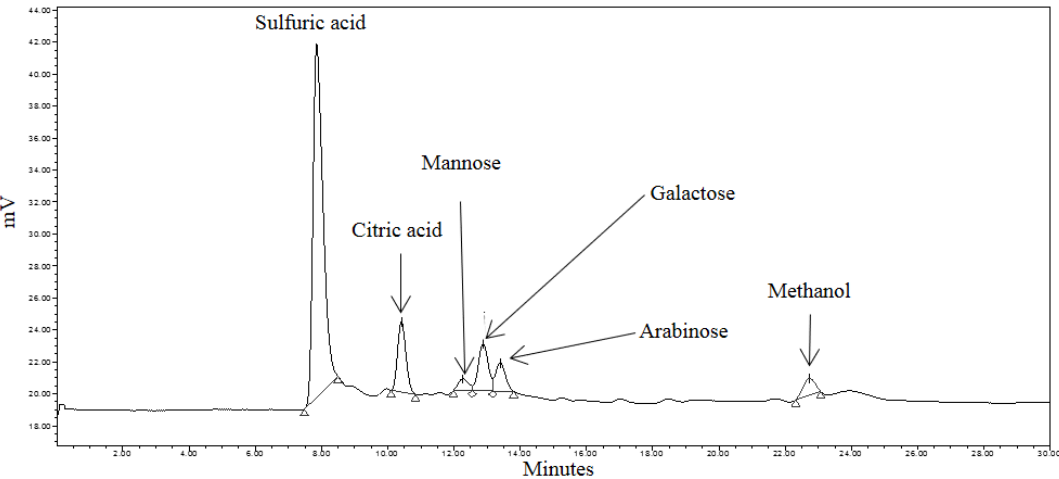
Figure 6. HPLC chromatogram of pretreated spent coffee waste sample.